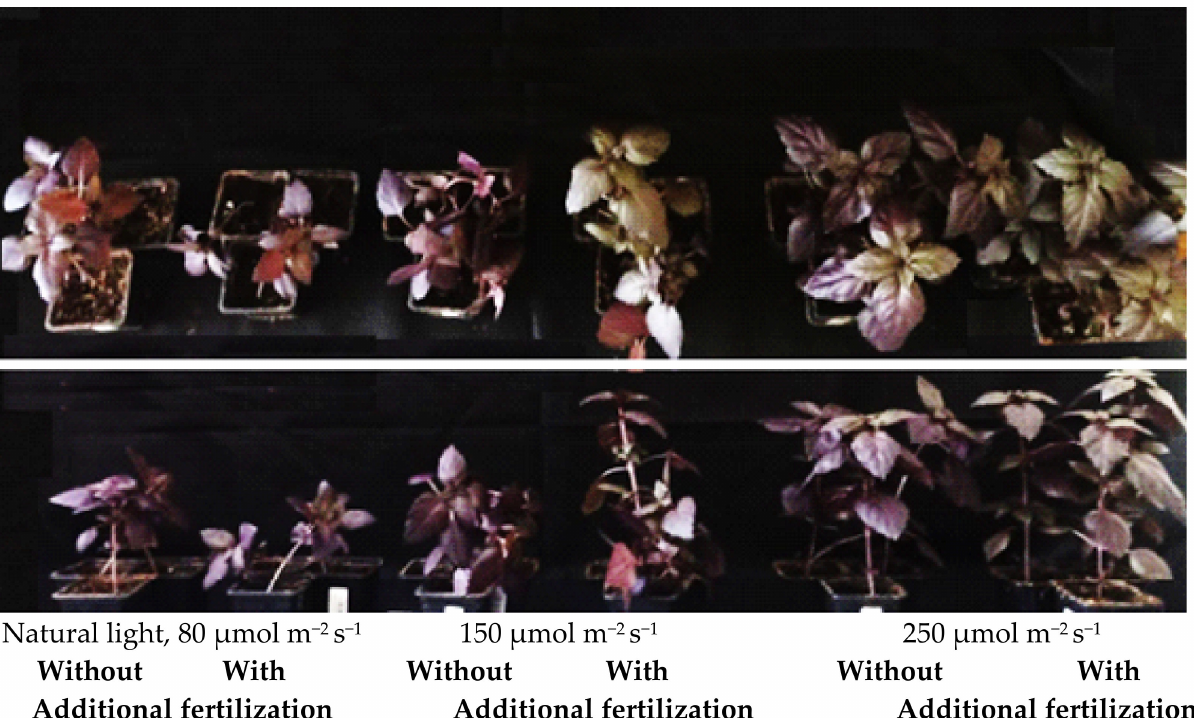
Figure 1. The effects of light intensity and fertilization on basil’s growth. Natural light corresponds to 4.6 mol m − 2 d − 1 ; 150 µ mol m − 2 s − 1 corresponds to 8.6 mol m − 2 d − 1 ; 250 µ mol m − 2 s − 1 corresponds to 14.4 mol m − 2 d − 1